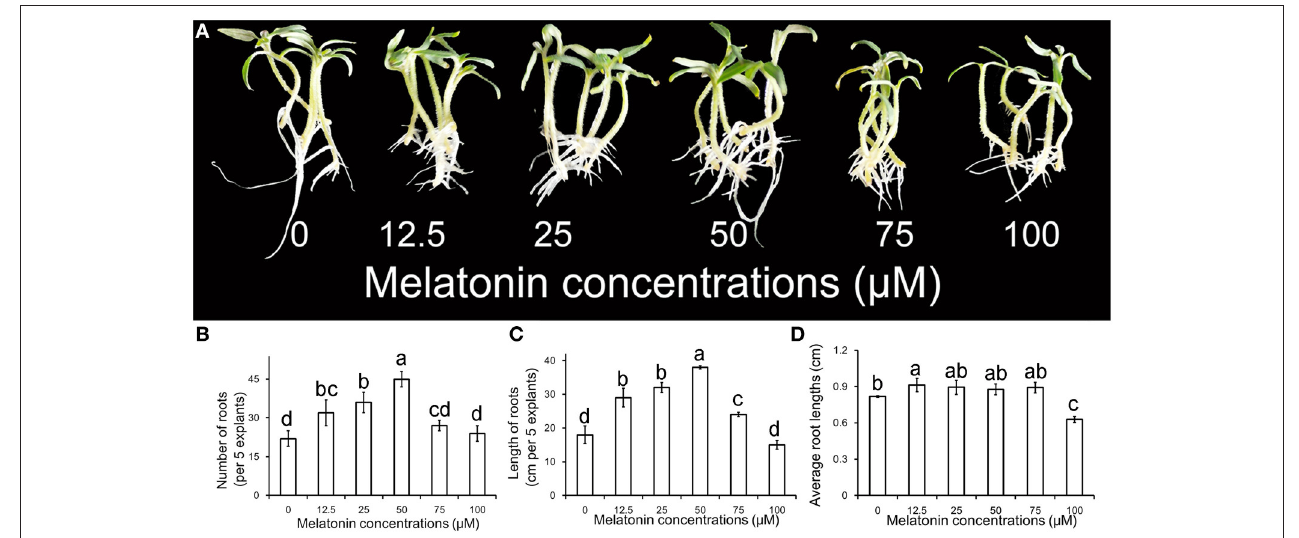
FIGURE 1 | Adventitious root formation in response to exogenous MT of different concentrations. (A) The primary root system was removed from hypocotyls of 10-days-old germinated tomato. Explants were incubated with 0, 12.5, 25, 50, 75, or 100 µ M MT. Photographs were taken after 6 days of treatments. (B) Root numbers in different concentrations of exogenous MT. (C) Root lengths in different concentrations of exogenous MT. (D) Average root lengths in different concentrations of exogenous MT. These are expressed as means of five replicates ± standard deviation (SD), and different letters indicate significant difference ( p <